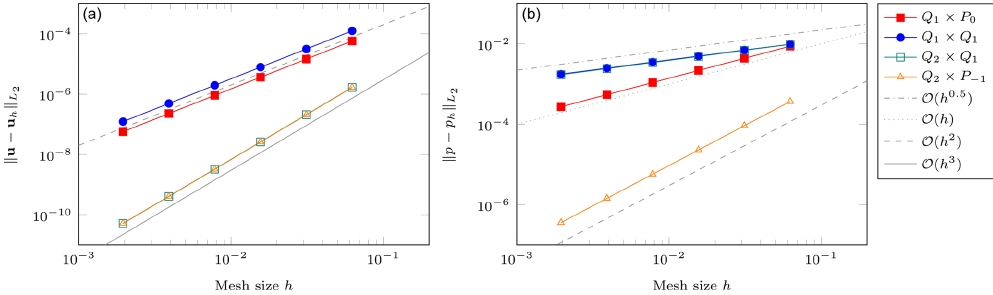
Figure 5. SolCx benchmark. Error convergence as a function of the mesh size h . (a) Velocity error; (b) pressure error.